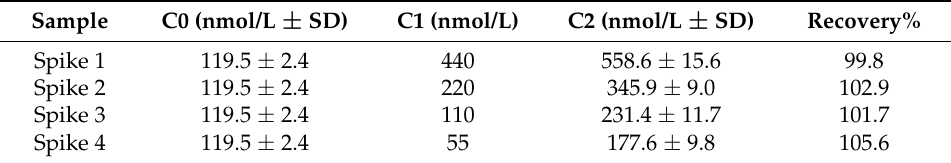
Table 1. Recovery experiments. C0 and C2 are the mean of three replicates.